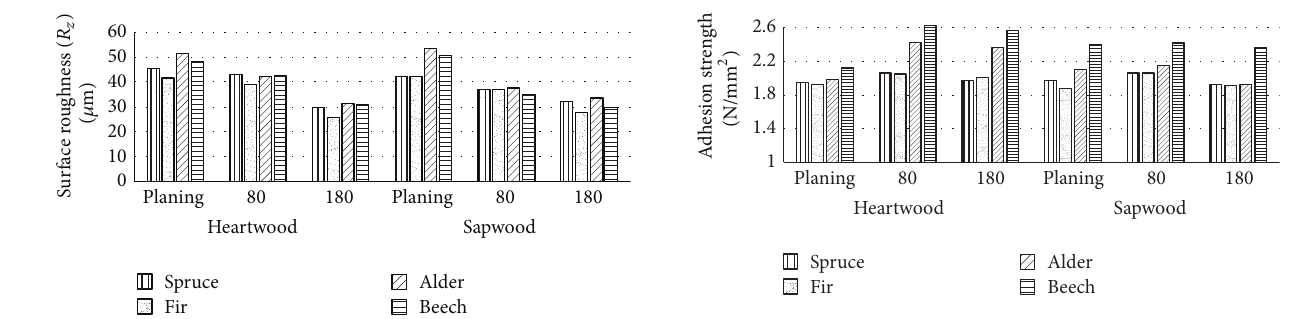
Figure 2: Adhesion strength values of the